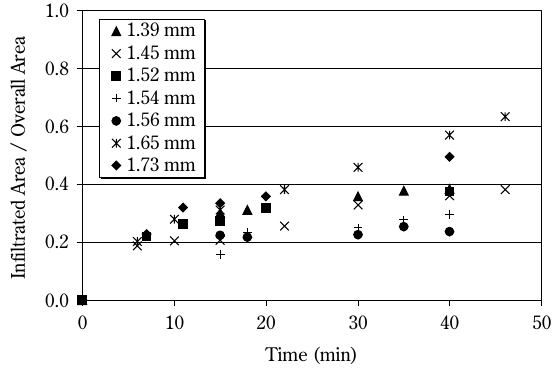
Median Hydrophilic Infiltration Median Hydrophobic Infiltration Fastest Hydrophilic Infiltration Slowest Hydrophobic Infiltration